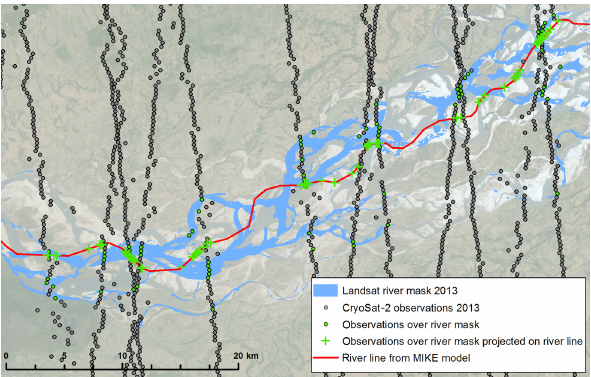
Figure 2. Section of the Brahmaputra in the Assam Valley show- ing the Landsat river mask, the CryoSat-2 observations and their mapping to the 1-D river model, all for